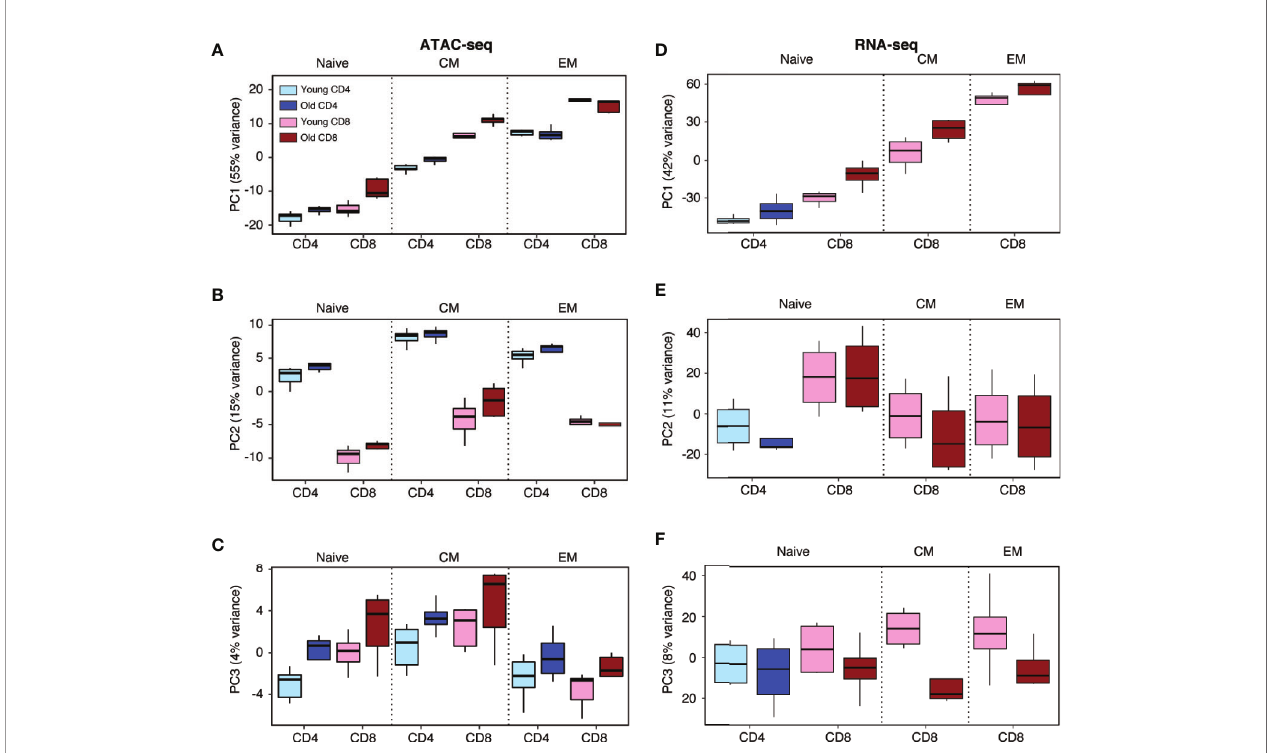
FIGURE 1 | Principal component analysis of CD4 and CD8 T cell subsets from young and old healthy individuals. (A – C) Principal component analysis (PCA) of ATAC-seq data of CD4 and CD8 naïve, central memory (CM) and effector memory (EM) T cells. Boxplots of PC1 (A) , PC2 (B) , and PC3 (C) of 5000 most variable sites of accessibility are shown for indicated T cell subsets from young and old individuals. PC1 segregated by differentiation (p = 0.006) and to a lesser degree by age (p = 0.042), PC2 by T cell lineage (p = 0.016) and PC3 trending to by age (p = 0.12). (D – F) PCA of RNA-seq data of naïve CD4 and CD8 naïve and CD8 CM and EM T cells from young and old individuals. Boxplots of PC1 (D) , PC2 (E) , and PC3 (F) of 500 most variable genes are shown for indicated T cell subsets from young and old